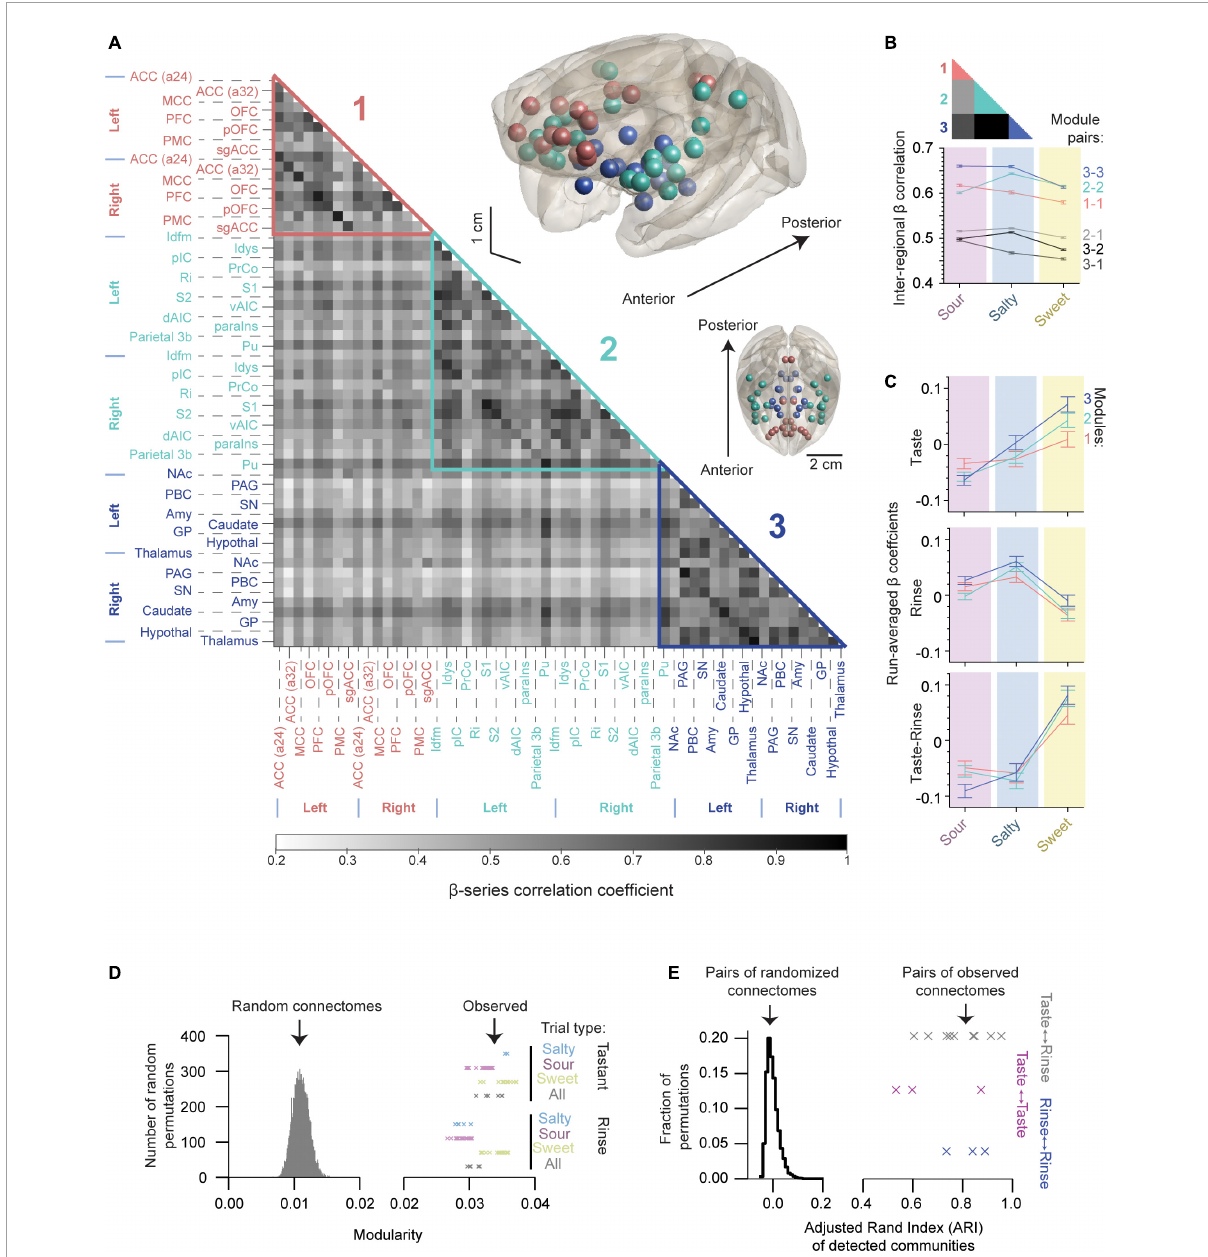
FIGURE5 The gustatory connectome is partitioned into three interconnected sub-networks. (A) Grayscale heat map of average pairwise inter-regional β -series correlation in the taste connectome ( n = 29 region pairs) with the detected modules highlighted. Three modules were revealed using the Louvain algorithm (modularity = 0.035): Module 1 (pink, n = 8 bilateral cortical regions), Module 2 (aqua, n = 12 bilateral cortical regions and putamen), and Module 3 (dark blue, n = 9 bilateral subcortical regions). Brain volume insets, shown in the upper right demonstrate the location of regions found within Modules 1 (pink spheres), 2 (aqua), and 3 (dark blue) relative to brain surface (gray transparent surface). (B) Line plot of average β -series correlation between modules (lower panel). Inset color codes the regions of matrix in panel (A) averaged to generate line plot. Region-wise correlations within and across modules indicate greater connectome-wide connectivity with sour and salty tastants as compared to sweet with the exception of Module 2-2 connections. (C) Line plot of β coefficients separated by detected modules (mean ± SEM, n = 4416, 6624, 4960 for Modules 1, 2, and 3, respectively). Note that the sweet taste generates the largest change in the β coefficients for all three modules. (D) Histogram of the modularity for random networks generated by permuting ( n = 10,000) the weights of connections in panel (A) . Crosses indicate the observed modularity values of the gustatory connectome during tastant (upper, n = 44) and rinse (lower, n = 56) presentations separated by the type of taste quality. Each cross indicates a unique partitioning starting from different initial random ordering of the connectome regions (see also Supplementary Figure 2 ). Note that none of the random networks reach the modularity levels observed in the gustatory connectomes. (E) Histogram of Adjusted Rand Index (ARI) for 10,000 random networks indicating their partitioning similarity. Crosses indicate the observed ARI for modules detected under different taste quality (sour, salty and sweet) presentations for tastant (magenta, n = 3), rinse (blue, n = 3), and tastant-to-rinse (gray, n = 9). The vertical location of crosses has only a visualization purpose in panels (D,E)